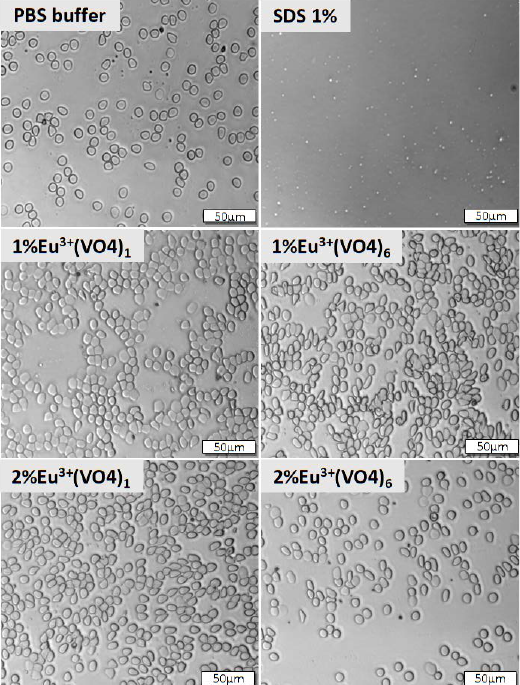
Figure 9. Red blood cell smear was performed with the use of purified sheep erythrocytes. For this experiment, selected compounds were used from the first series: Ca 9.9 Eu 0.1 (PO 4 ) 5 (VO 4 ) 1 (OH) 2 , Ca 9.9 Eu 0.1 (VO 4 ) 6 (OH) 2 and from the second series: Ca 9.8 Eu 0.2 (PO 4 ) 5 (VO 4 ) 1 (OH) 2 , Ca 9.8 Eu 0.1 (VO 4 ) 6 (OH) 2 . The final concentration of the tested compounds was estimated at 100 µ g/mL. The morphology of red blood cells treated with the tested compounds was compared with that of red blood cells treated with PBS buffer (negative control) and 1% SDS (positive